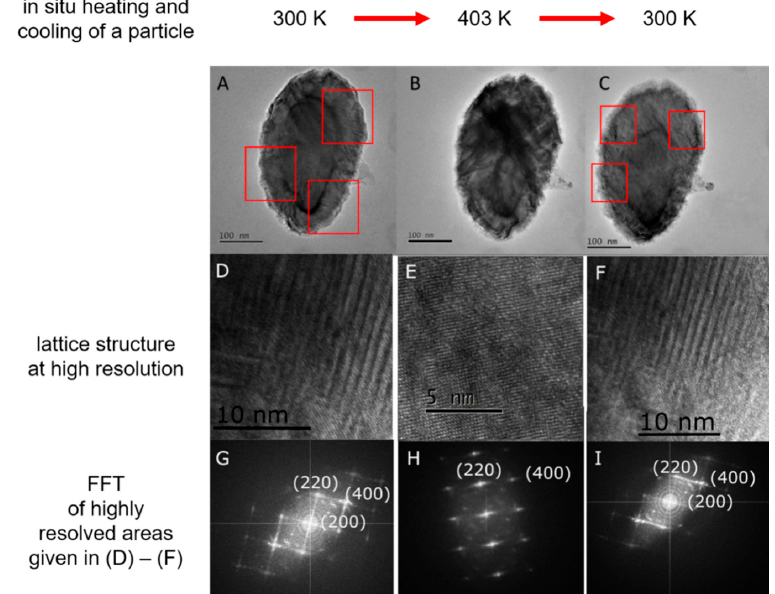
Figure 6. Martensitic transformation in a single elliptical disc-shaped Heusler Ni 50 Mn 32.5 Ga 17.5 particle, which is about 377 nm long, 234 nm wide and only 60 nm thick [42]. ( Upper row ) TEM pictures ( A – C ) of the morphology of the same Heusler Ni 50 Mn 32.5 Ga 17.5 particle upon temperature change. Size and form of the particle are not changing; ( Middle row ) High-resolution transmission electron microscopy (HRTEM)images of the corresponding lattice changes. ( D , F ) clearly show the modulated martensite lattice structure, whereas ( E ) is representative for the cubic austenitic lattice structure; (Lower row) Corresponding fast Fourier transforms (FFT) of the highly resolved areas provided in ( D – F ). The streaks seeing in ( G ) and ( I ) confirm the modulated martensite. ( H ) Shows the FFT of a cubic structure.